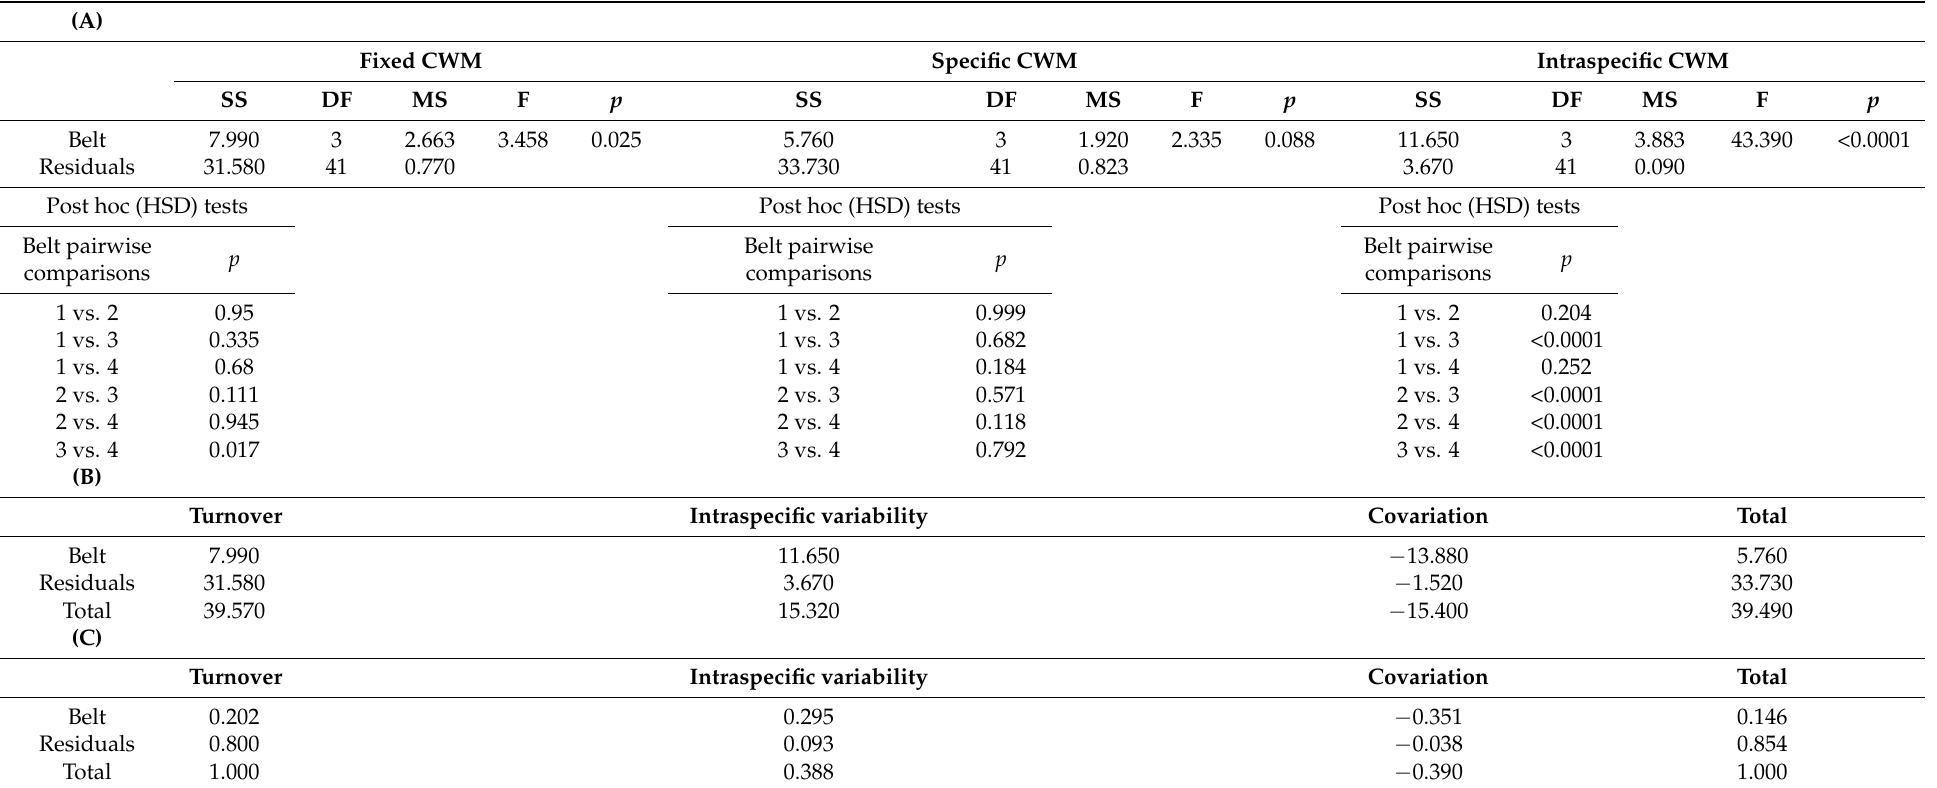
Table 3. Results of ANOVAs for CWM of specific leaf area (SLA). ( A ) ‘Fixed’ and ‘specific’ averages and intraspecific variability effect were analyzed separately (one-way ANOVA), followed by post hoc (HSD) tests for pairwise comparisons. ( B ) Variability of individual components of trait variation (turnover, intraspecific and their covariation) between belts. ( C ) Proportions of variability of individual components and their parts explained by elevation (belt). For details, see Table